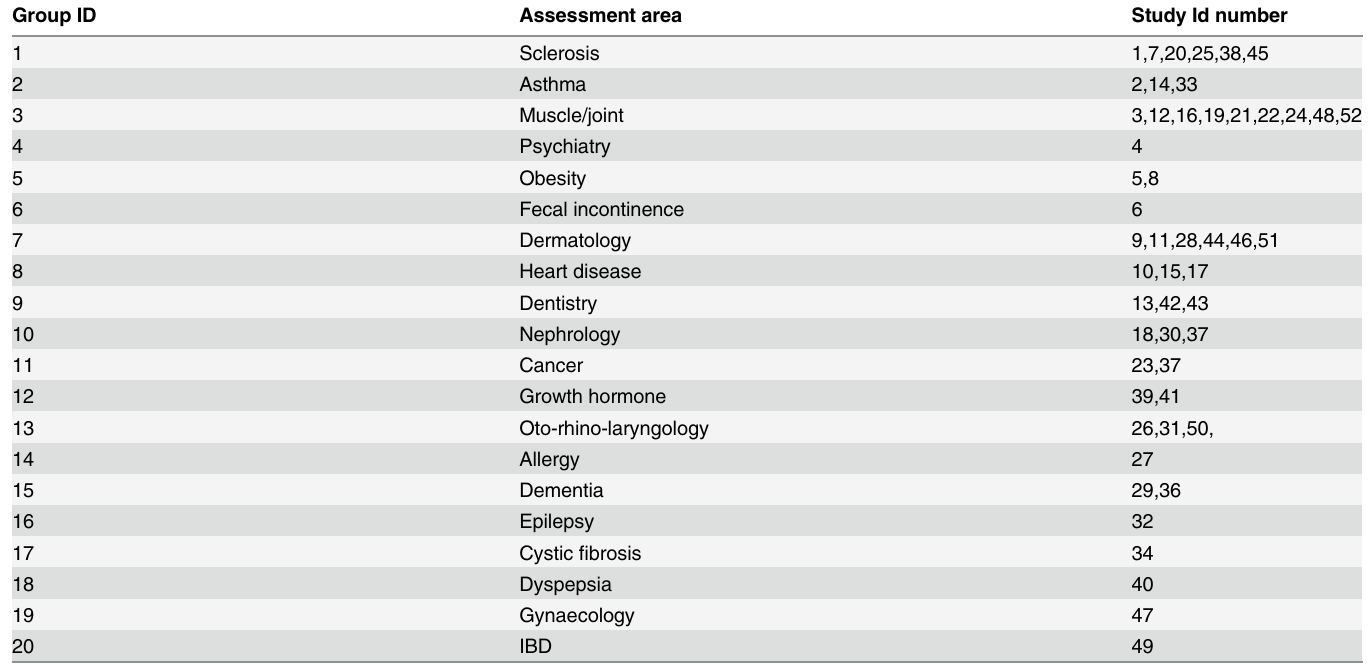
Table 1. Showing assessment area for each study included in the analysis. Group